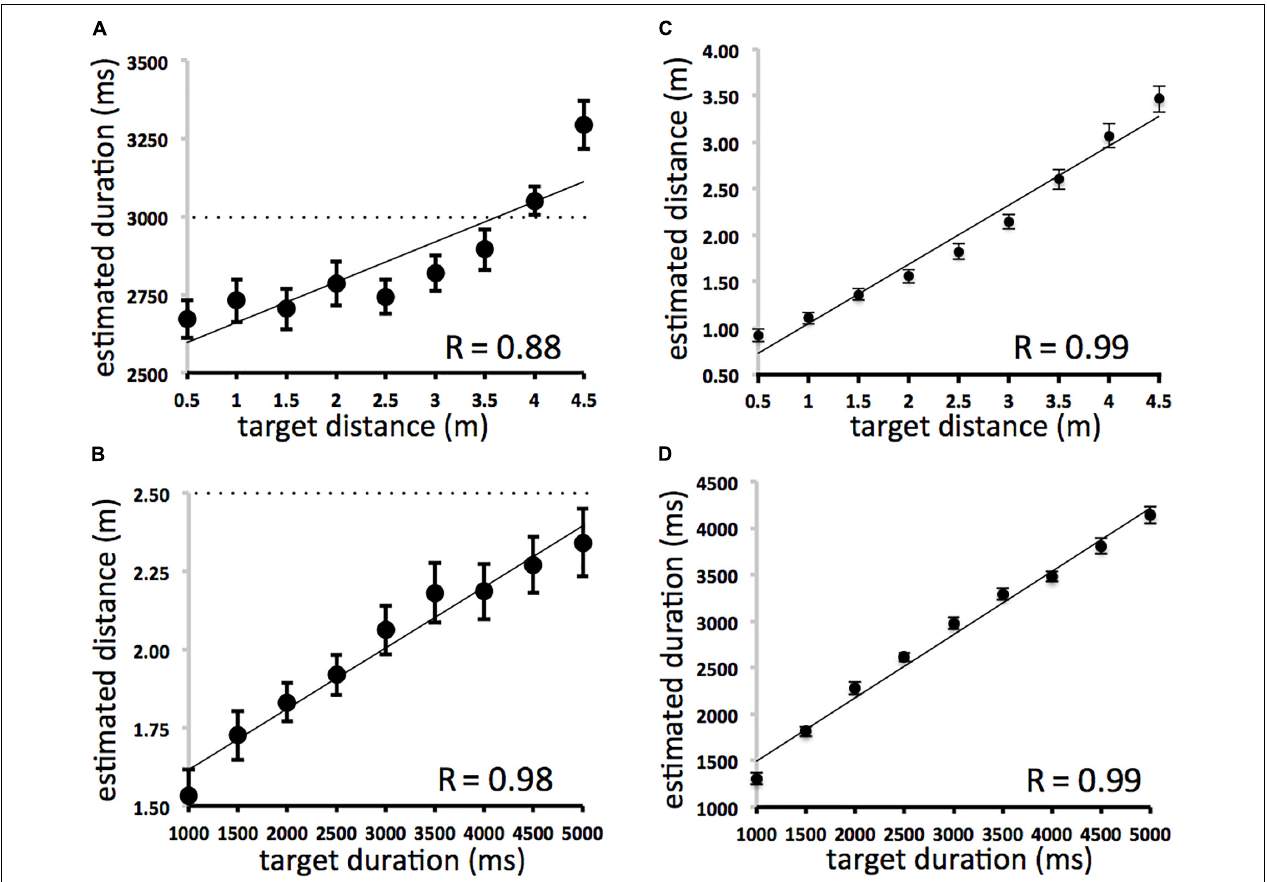
FIGURE 1 | (A–D) Averaged duration and spatial displacement estimates. Scatterplots (A) (SPACE → TIME) and (B) (TIME → SPACE) on left depict between domain effects. The dotted lines represent the line predicted by perfect performance. All space and time intervals were fully crossed. The average of all nine duration intervals is 3000 ms at each displacement length (A) and the average of all nine displacement intervals is 2.5 m at each duration (B) . Scatterplots (C) (SPACE → SPACE) and (D) (TIME → TIME) on the right depict within domain effects. Error bars refer to standard error of the